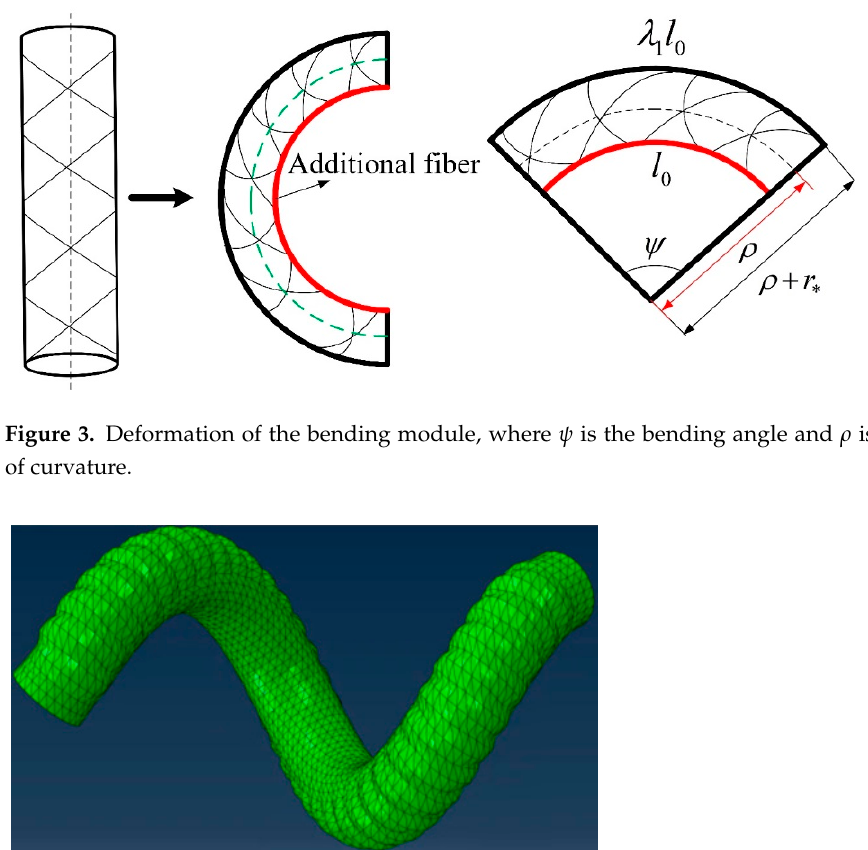
ρ is the radius